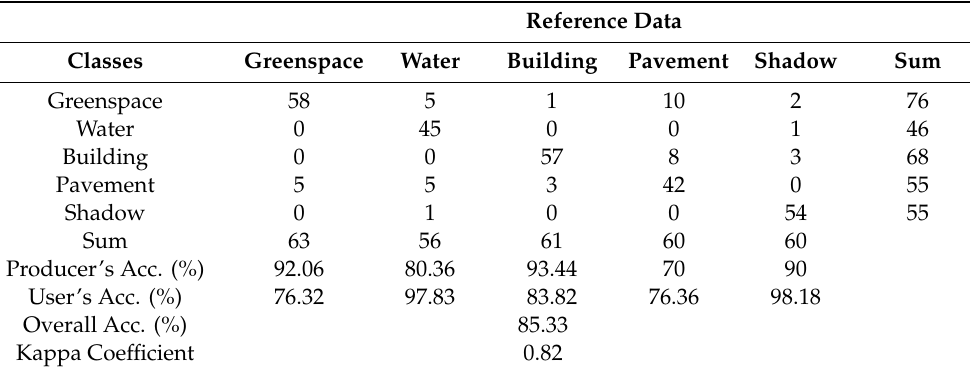
Table 6. The classification accuracies in Method